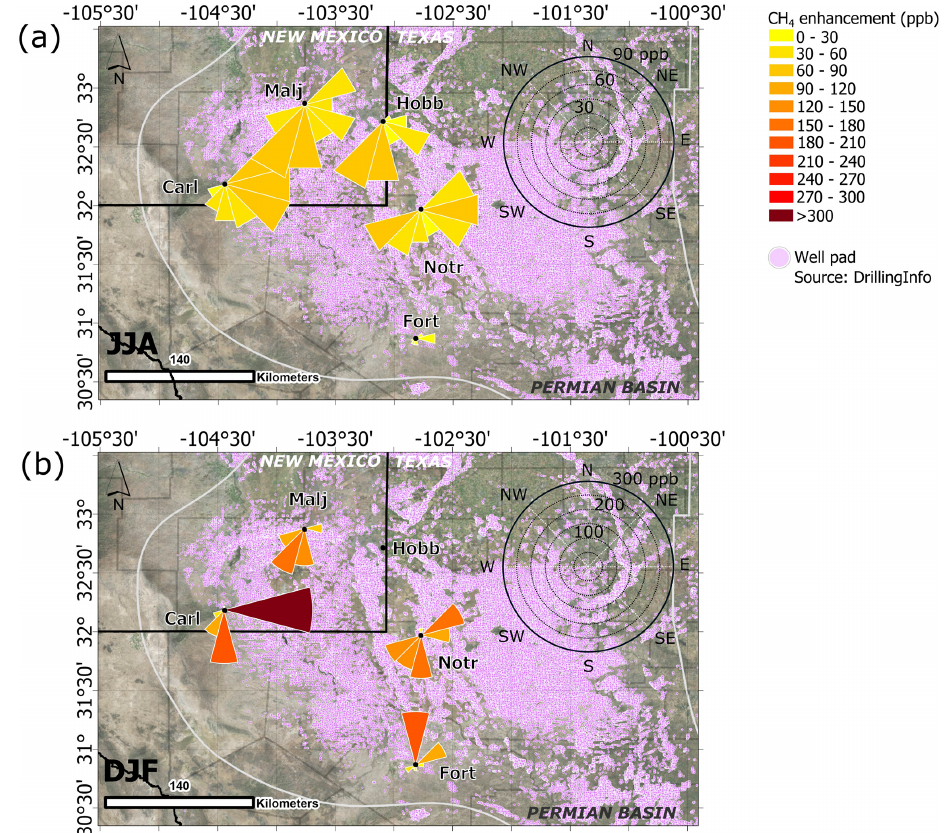
Figure 7. Methane enhancements at each tower location. The background for the figures indicates individual well locations for the Permian Basin. (a) CH 4 enhancements during summer months, i.e., June, July, August (JJA). (b) CH 4 enhancements during winter months, i.e., December January, February (DJF). The “triangles” represent the mean of the afternoon (20:00–23:00 UTC) enhancements coming from the indicated direction. The gray boundary delimits the Permian Basin, while the black line is the boundary between New Mexico and Texas. Credits for base map: Esri, DigitalGlobe, GeoEye, Earthstar Geographics, CNES/Airbus DS, USDA, USGS, AeroGRID, IGN, and the GIS User